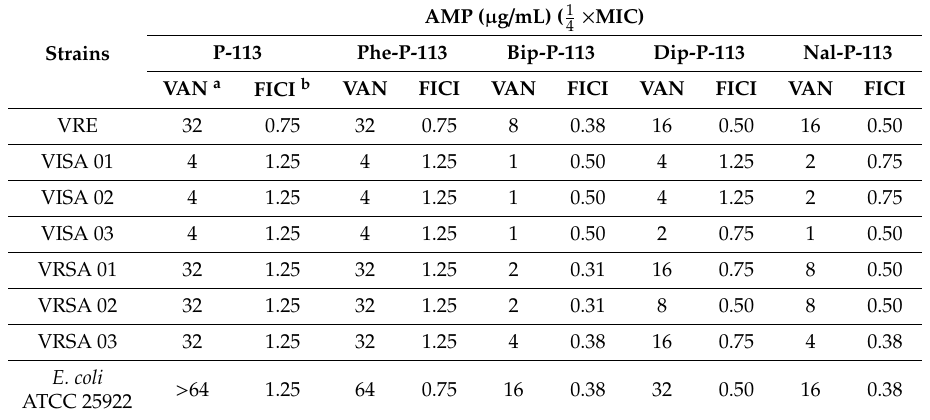
Table 3. Synergistic e ff ects of P-113, Phe-P-113, Bip-P-113, Dip-P-113, and Nal-P-113 in combination with vancomycin against bacterial strains studied. All of the experiments were performed in triplicate.